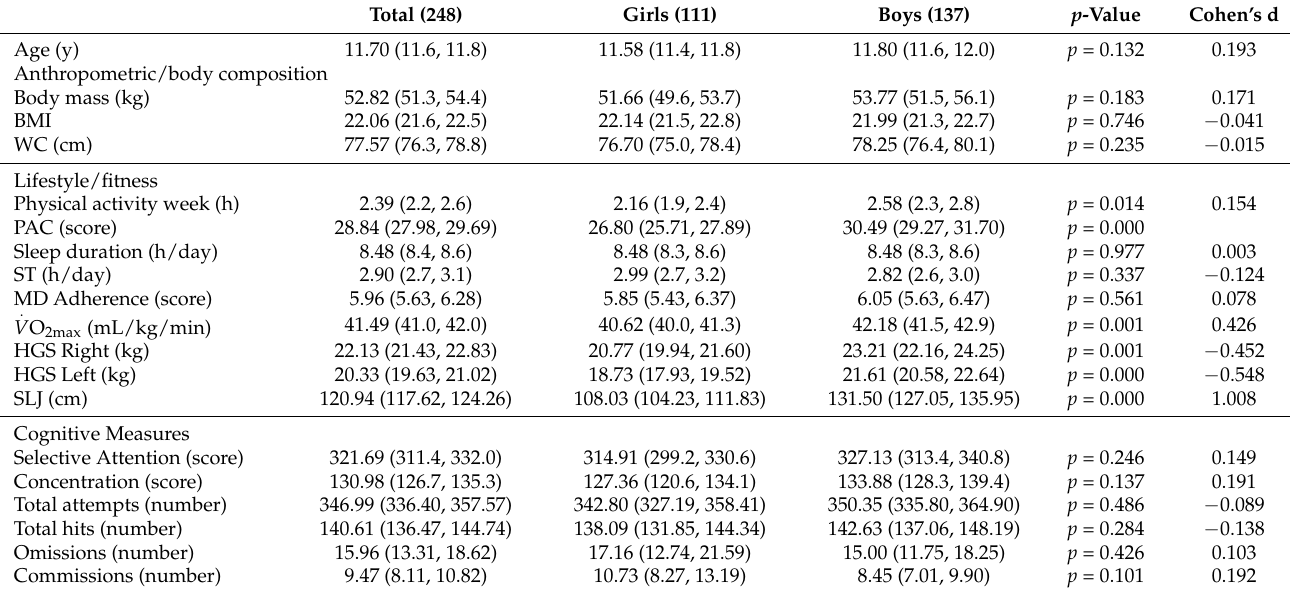
Table 1. Baseline characteristics of the schoolchildren participants by sex at the level of anthropometry, cardiorespiratory fitness, physical activity patterns, concentration and selective